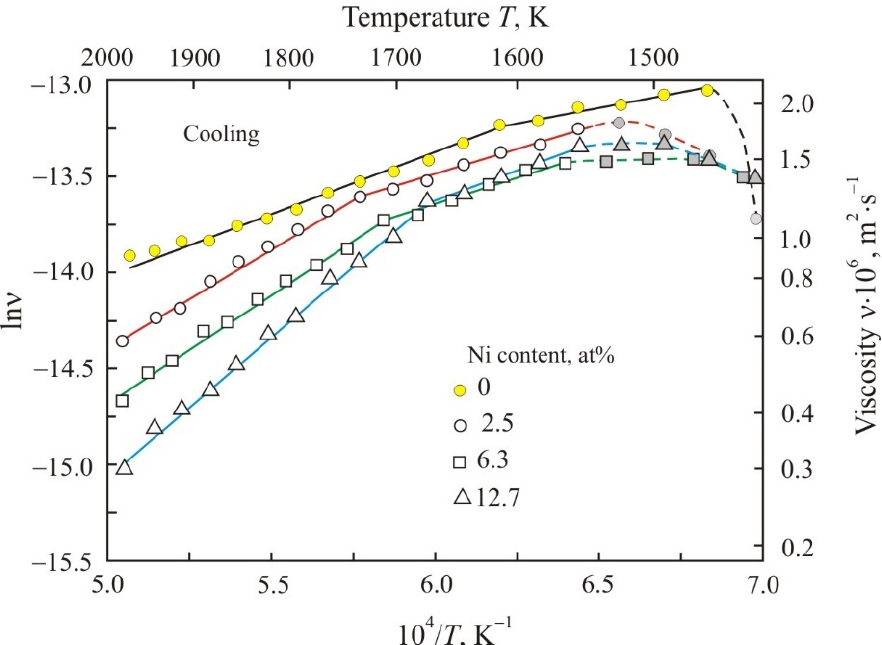
Figure 5. Kinematic viscosity on a natural logarithmic scale ln ν as a function of the inverse absolute temperature T − 1 upon cooling after heating to maximum temperature T max = 1985 K the Fe 72.5 − x Ni x Cu 1 Nb 2 Mo 1.5 Si 14 B 9 alloys with Ni content 0; 2.5; 6.3; and 12.7 at. %.